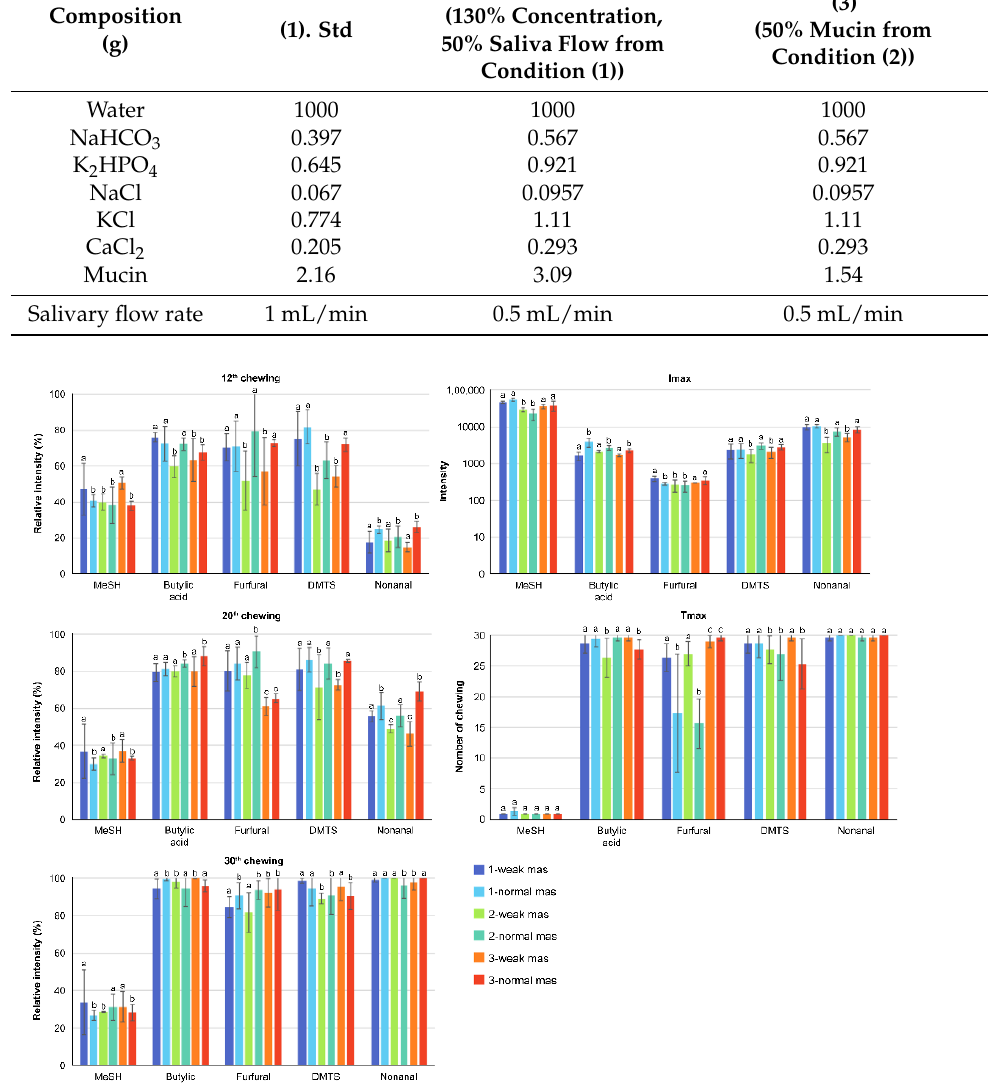
Figure 5. Changes in the release of aroma compounds due to differences in the strengths of masti- cation and in saliva composition and flow. Statistical analyses were performed independently for each aroma compound. Different letters on top of bars mean significant differences ( α =